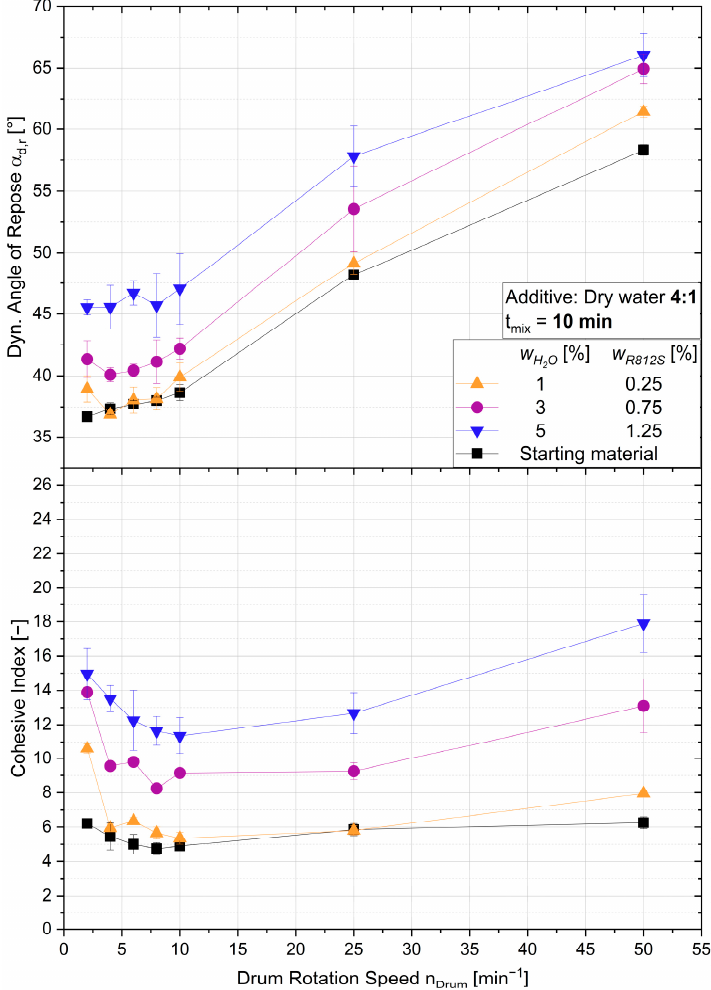
Figure 8. Typical curve progression regarding the dynamic angle of repose and cohesive index for mixtures with dry water (H 2 O:R812S) in dependence of the drum rotational speed and varying water contents.